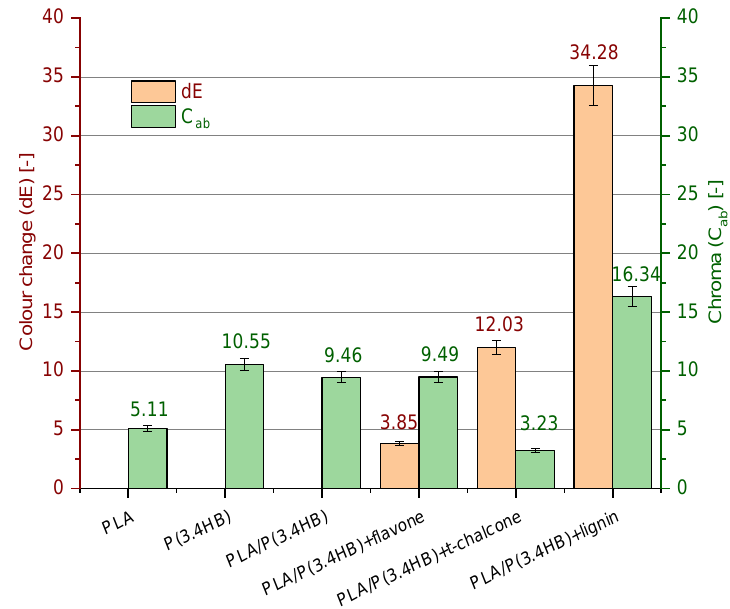
Figure 7. Colour change (dE) (-) and Chroma ( C ab ) (-) results of PLA / P(3.4 HB) composites with selected natural antioxidants in comparison to reference PLA. P(3.4 HB) and PLA / P(3.4 HB) samples.